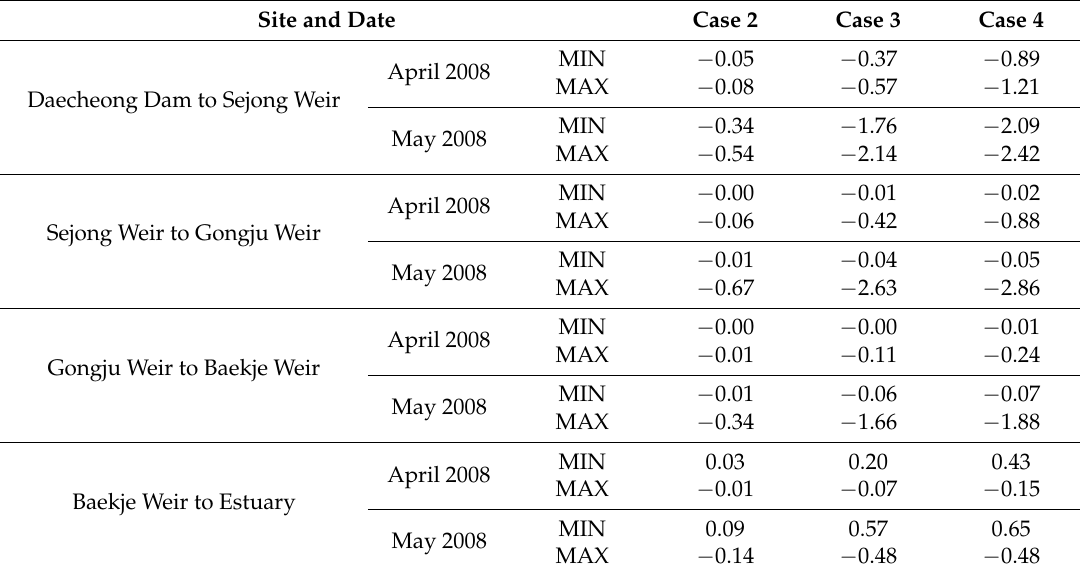
Table 9. Comparison of the difference in BOD (mg · L − 1 ) between Case 1 and all other cases. Site and Date Case